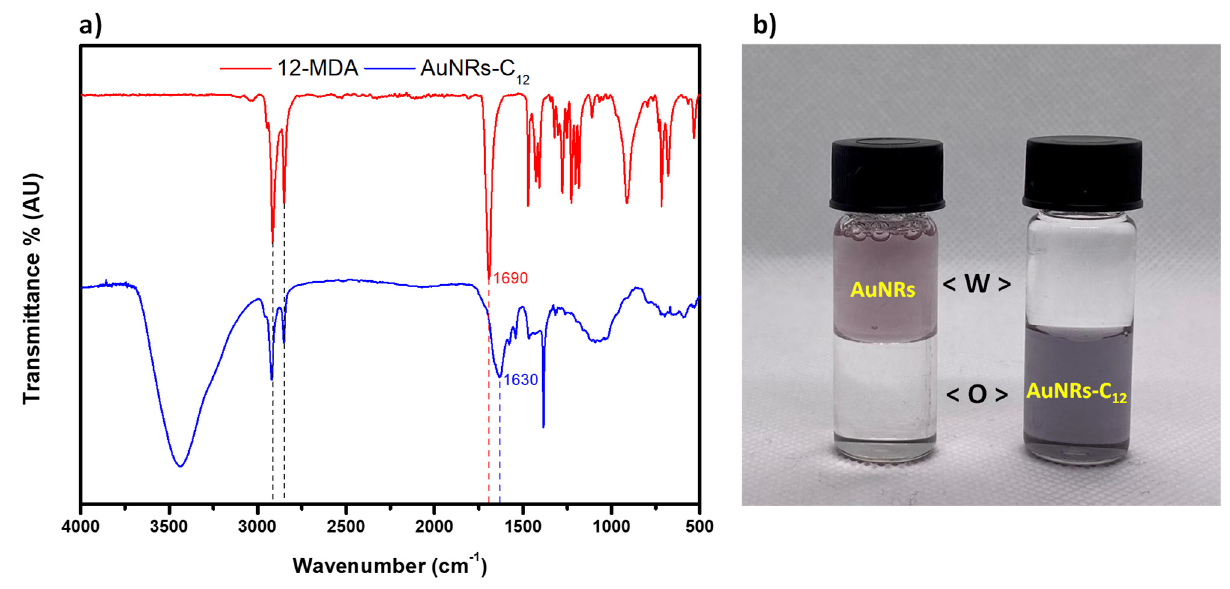
Figure 2. AuNRs hydrophobic coating analyses. ( a ) FT-IR spectra of 12-MDA (red) and 12-MDA- coated AuNRs (blue). ( b ) Visual inspection of the O/W (CHCl 3 /H 2 O) partition equilibria of native AuNRs ( left ) and AuNRs-C 12 ( right ).